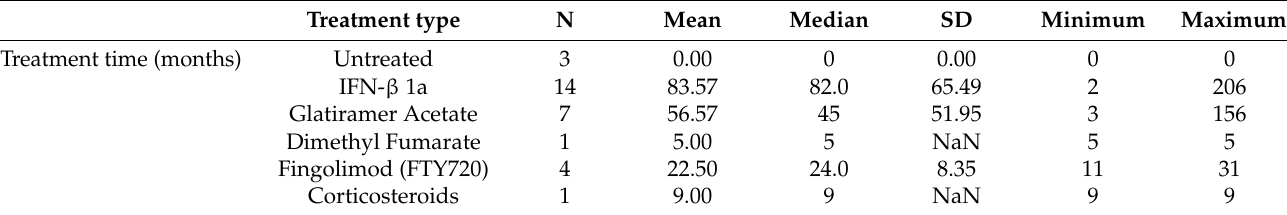
Table 3. Distribution of patients by treatment type with treatment